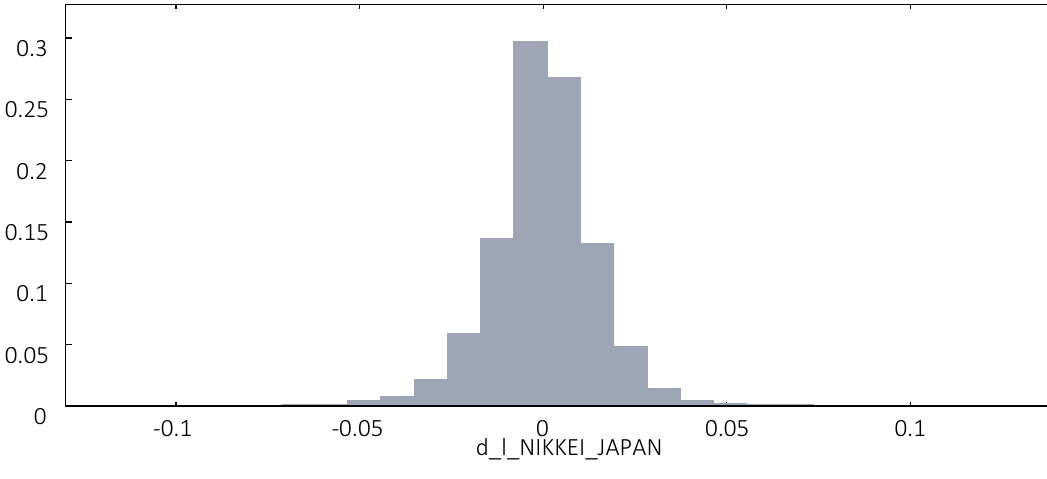
Figure 4. Relative frequency distribution for NIKKEI 225 index during the sample